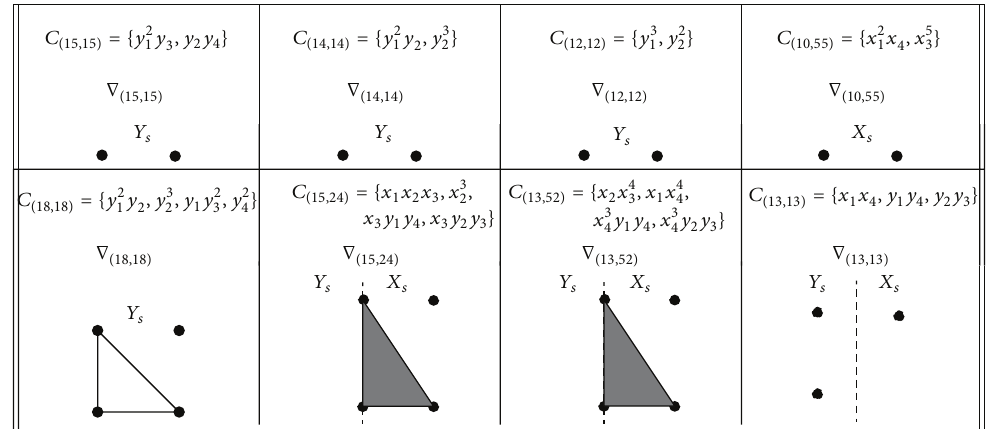
Figure 1: Nonconnected simplicial complexes associated with Betti (𝑆)